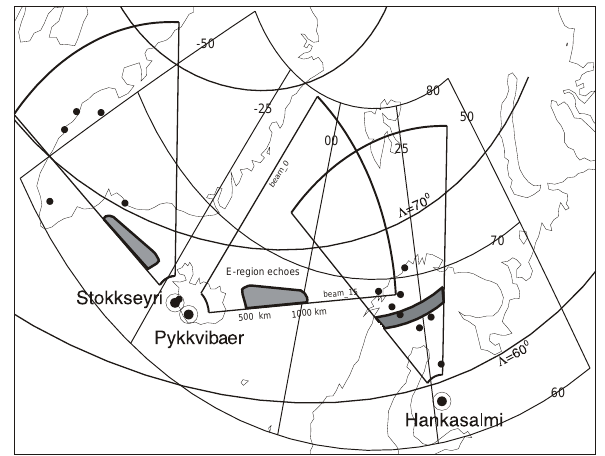
Fig. 1. Viewing zones of the Stokkseyri, Pykkvibaer and Fin- land HF radars on a geographical grid (dots). The solid lines are the PACE magnetic latitudes. The large dots are locations of IM- AGE, DMI-Greenland and Iceland magnetometers. The toned areas correspond to the regions of high-velocity E-region echoes occur- rence (for the Iceland radars) and the band of low-velocity E-region echoes observed simultaneously by the Finland